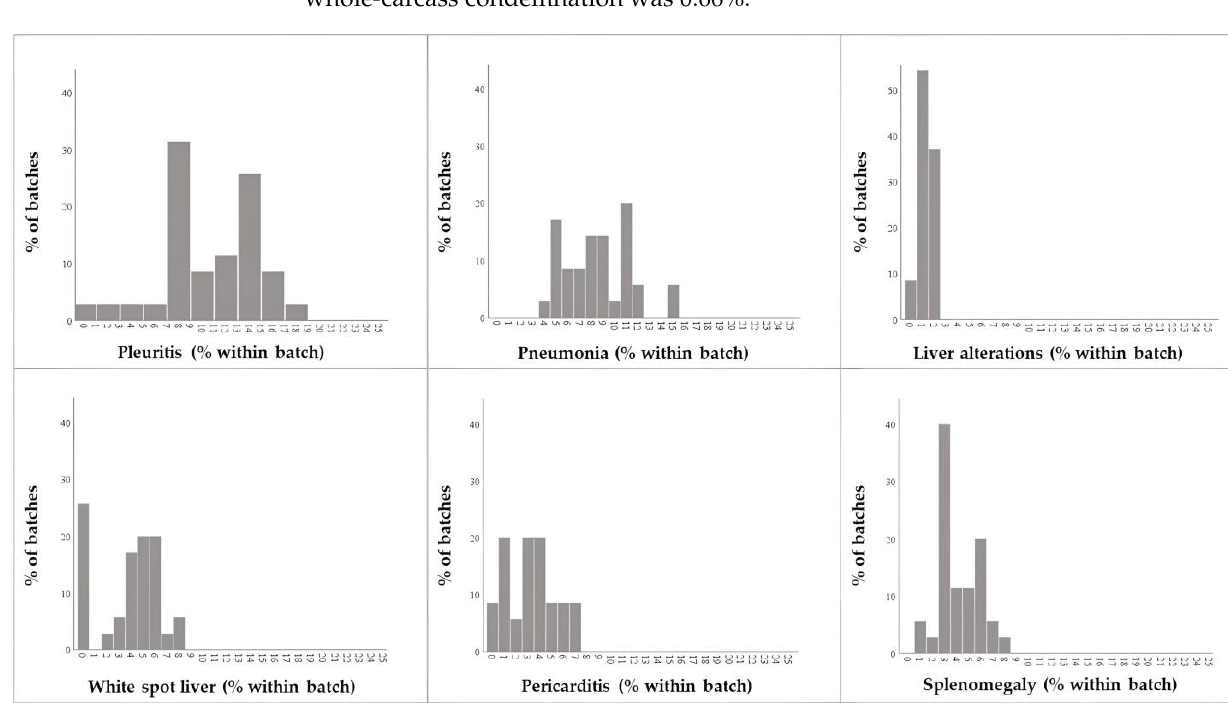
Figure 2. Frequency distributions of the highest within-batch prevalence of post-mortem lesions recorded in slaughtered pigs ( N = 35 batches).